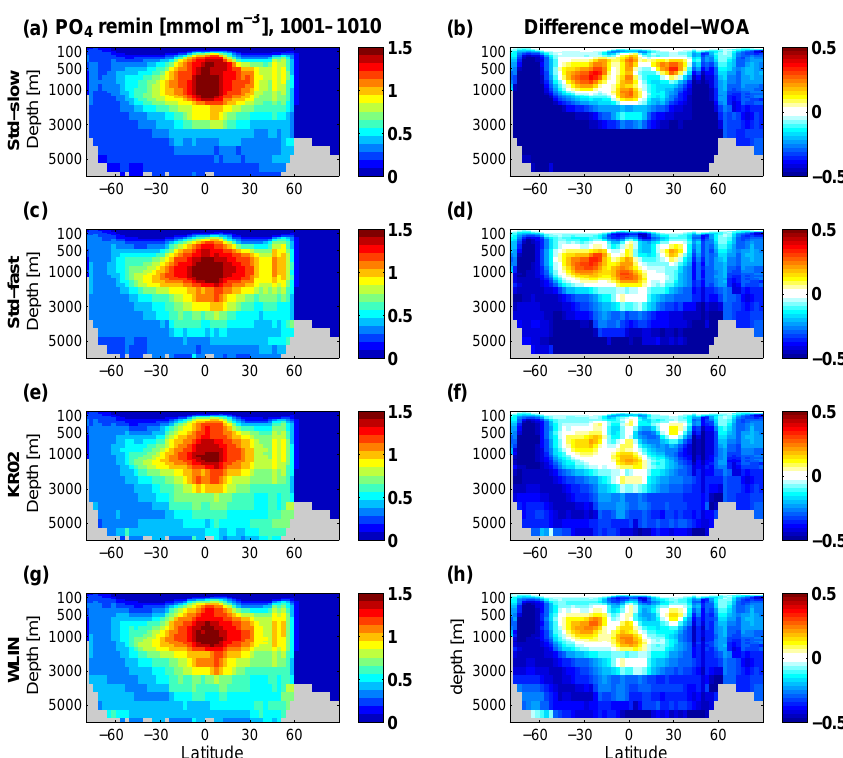
Figure 24. Global zonal mean concentrations of remineralised phosphate (mmolm − 3 ) averaged over the last 10 years of the spin-up simu- lations employing the (a) STD-slow, (c) STD-fast, (e) KR02, and (g) WLIN particle sinking parameterisations. Panels (b, d, f, h) show the differences with respect to the World Ocean Atlas gridded data set. The remineralised fraction of phosphate is approximated by apparent = 172 used in the model. oxygen utilisation (AOU) divided by the stoichiometric oxygen to phosphorus ratio R O 2 : P